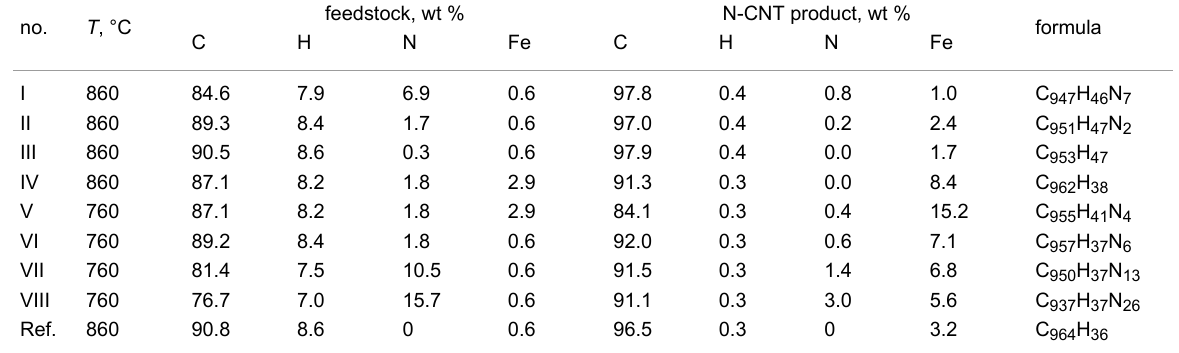
Table 3: Elemental composition of the feedstock vs N-CNT products from Syntheses I-VIII in a comparison with MWCNTs. no.